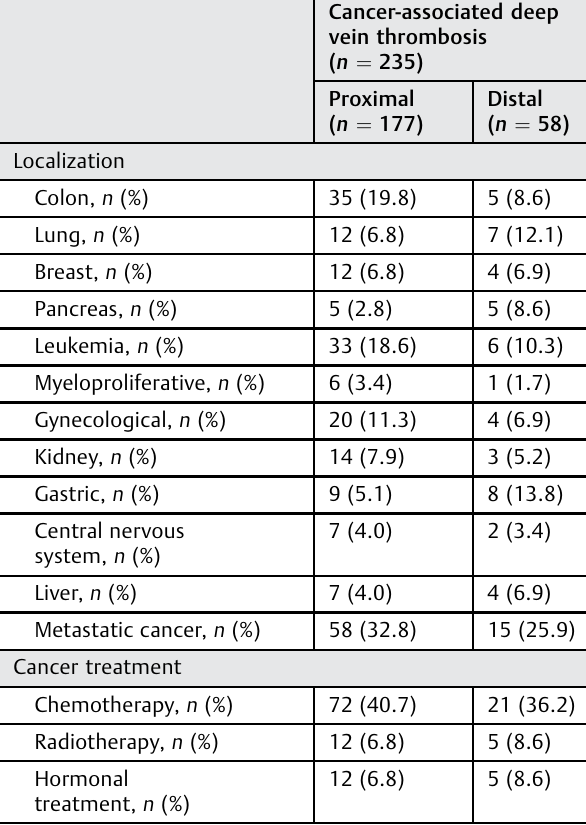
Table 2 Localization of cancer and ongoing cancer treatment in patients with proximal or distal deep vein thrombosis